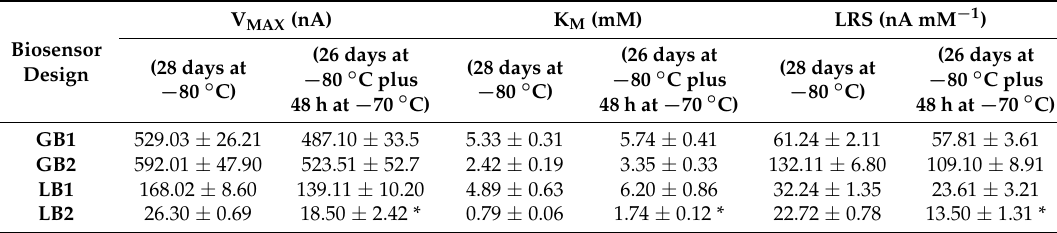
Table 1. Biosensor kinetic parameters obtained after different storage conditions. Four groups of biosensors ( n = 4 per design) were stored at − 80 ◦ C for 28 days and calibrated immediately after stabilization in PBS at RT. Further four groups of biosensors were used for simulating the transport in dry ice by storing the biosensors at − 70 ◦ C for 48 h after a period of 26 days at − 80 ◦ C. * = p < 0.05 vs. the corresponding biosensor group stored at − 80 ◦ C for 28